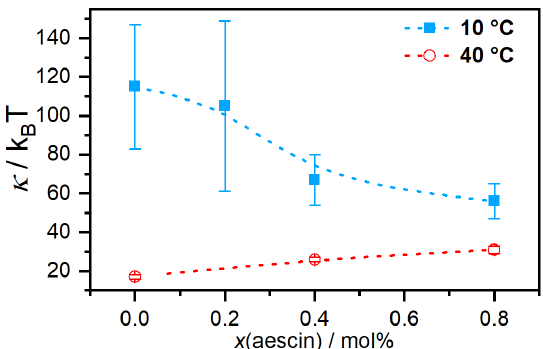
Figure 9. Bilayer bending modulus κ as function of β -aescin content for 10 ◦ C and 40 ◦ C. Dotted lines are guides to the eye. Reproduced from Ref. [47] with permission from the PCCP Owner